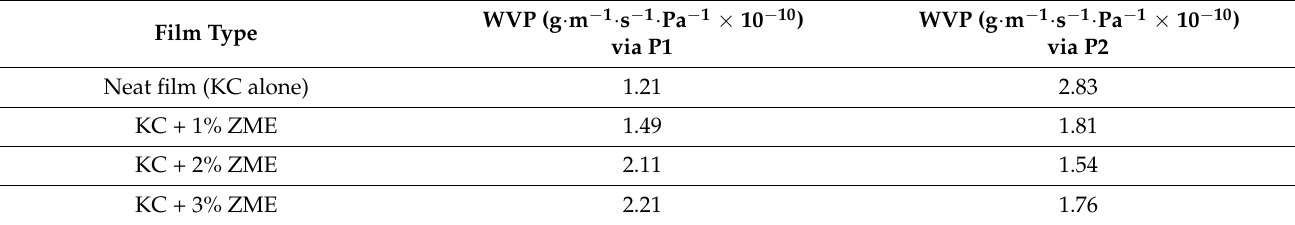
Table 6. WVP values of the kappa-carrageenan (KC) composites via two different procedures (P1 and P2) (taken (abridged) from [55] with permission from